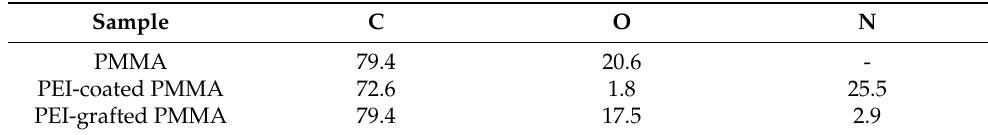
Figure 5. C 1s and N 1s analysis measured by XPS for bare PMMA, PEI-coated PMMA, and PEI- grafted PMMA. Table 1. Surface elemental